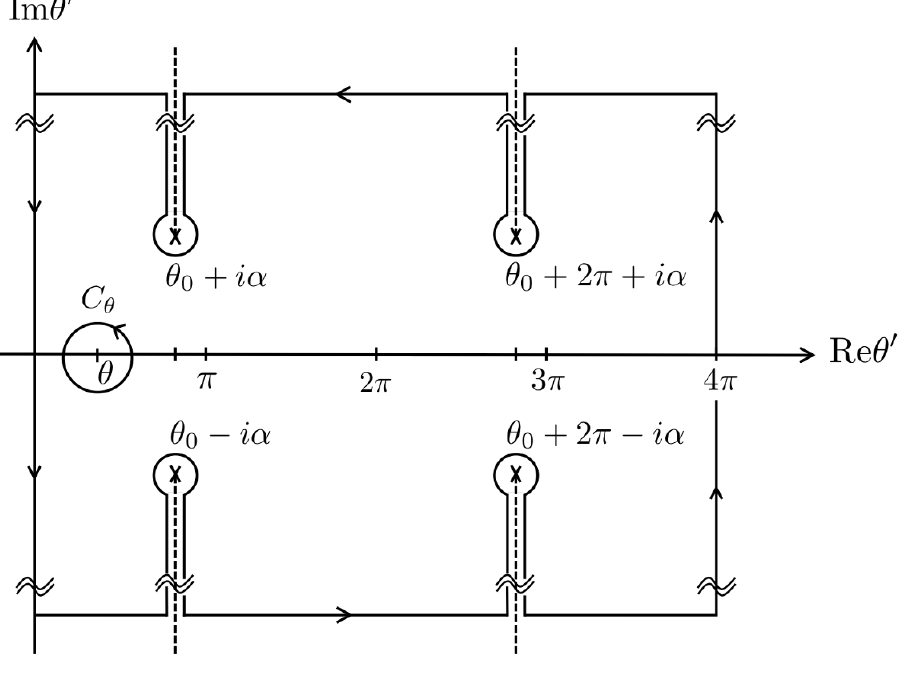
Figure 4 . The contour